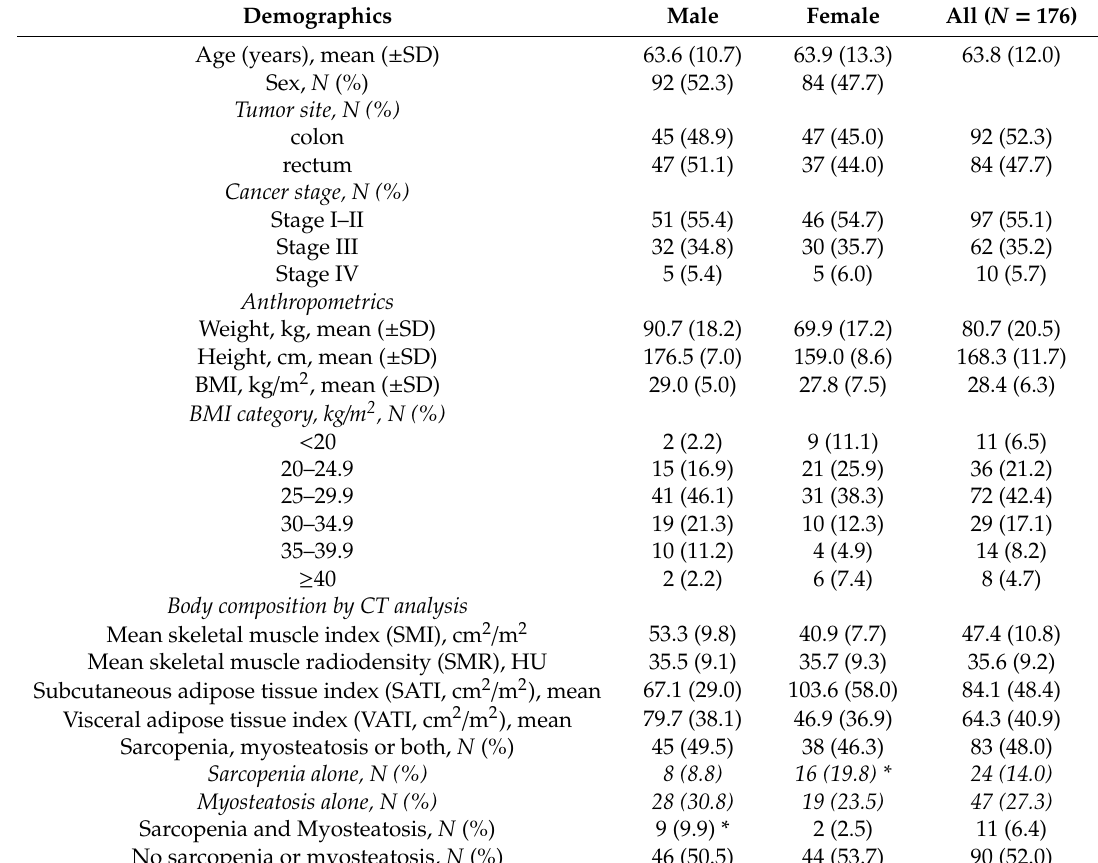
Table 1. Characteristics of pre-operative colorectal cancer